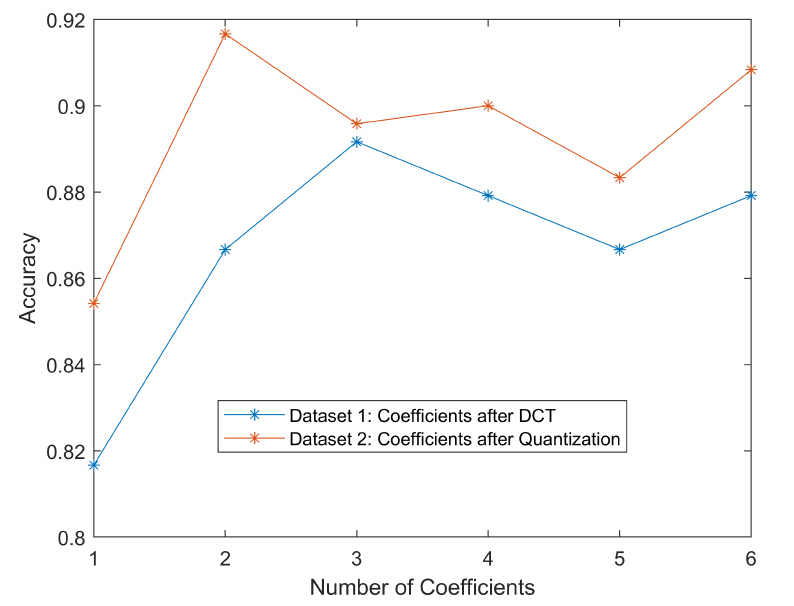
Figure 6. Classification accuracies on coefficients after DCT and after quantization. Generally, an increasing number of DCT coefficients leads to higher accuracies.